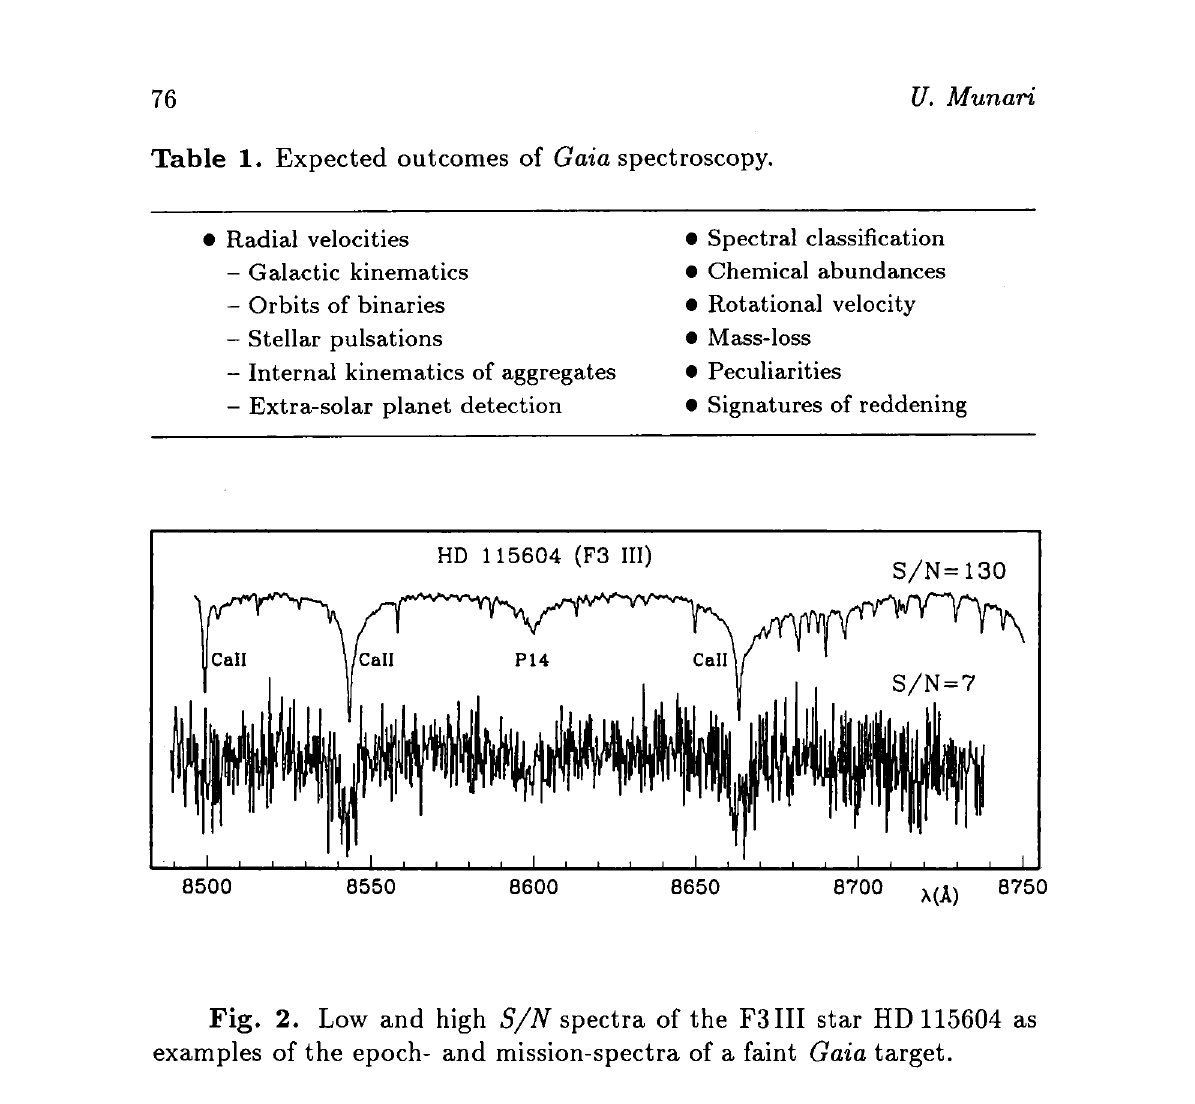
Fig. 2. Low and high S/N spectra of the F3III star HD 115604 as examples of the epoch- and mission-spectra of a faint Gaia